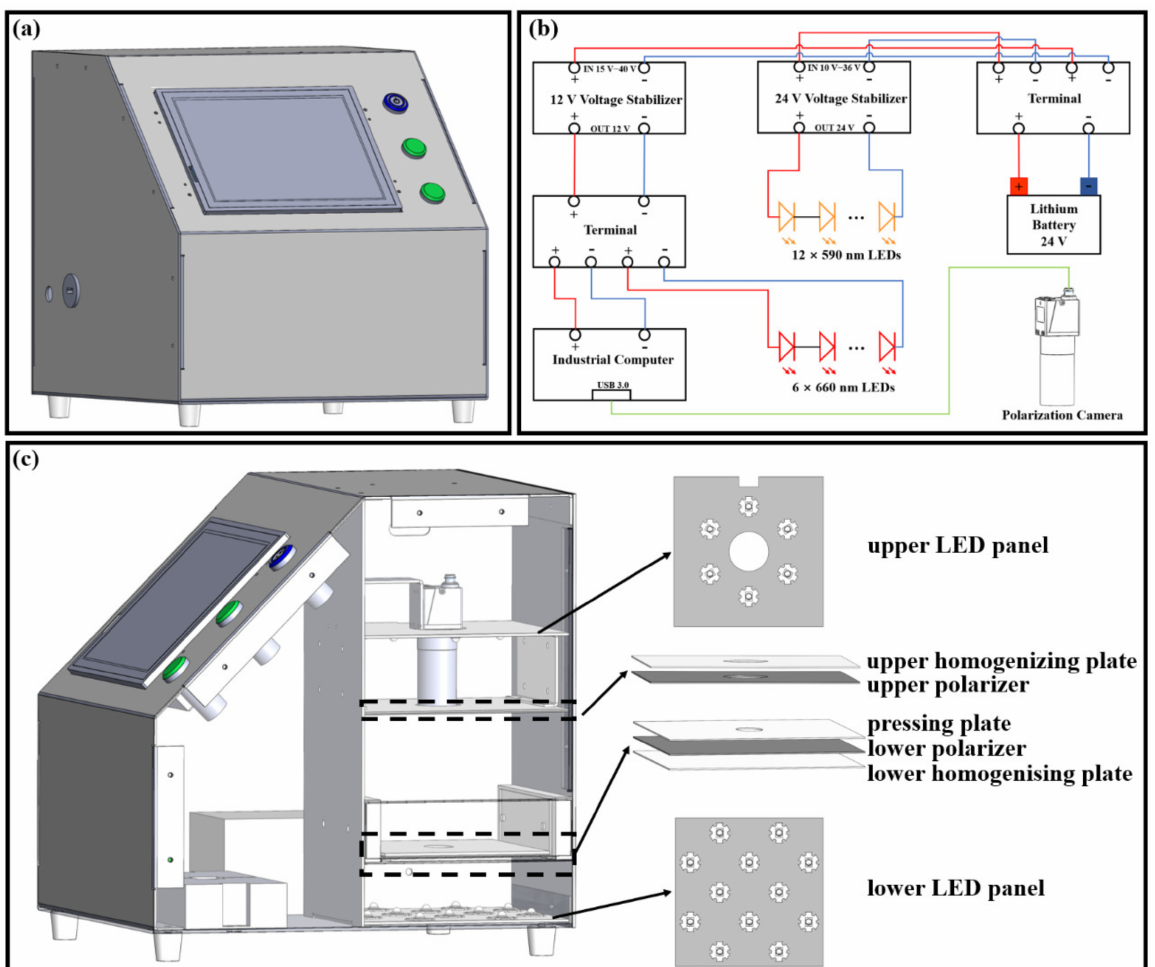
Figure 3. Custom-developed vision system: ( a ) appearance of the vision system; ( b ) circuit diagram of the power supply module; ( c ) schematic diagram of the image acquisition